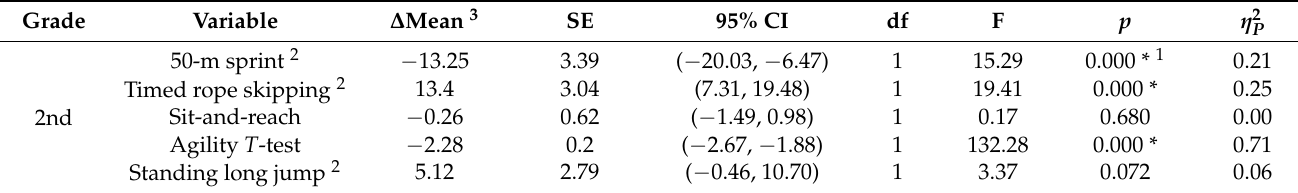
Table 5. Changes between-group by grade after the